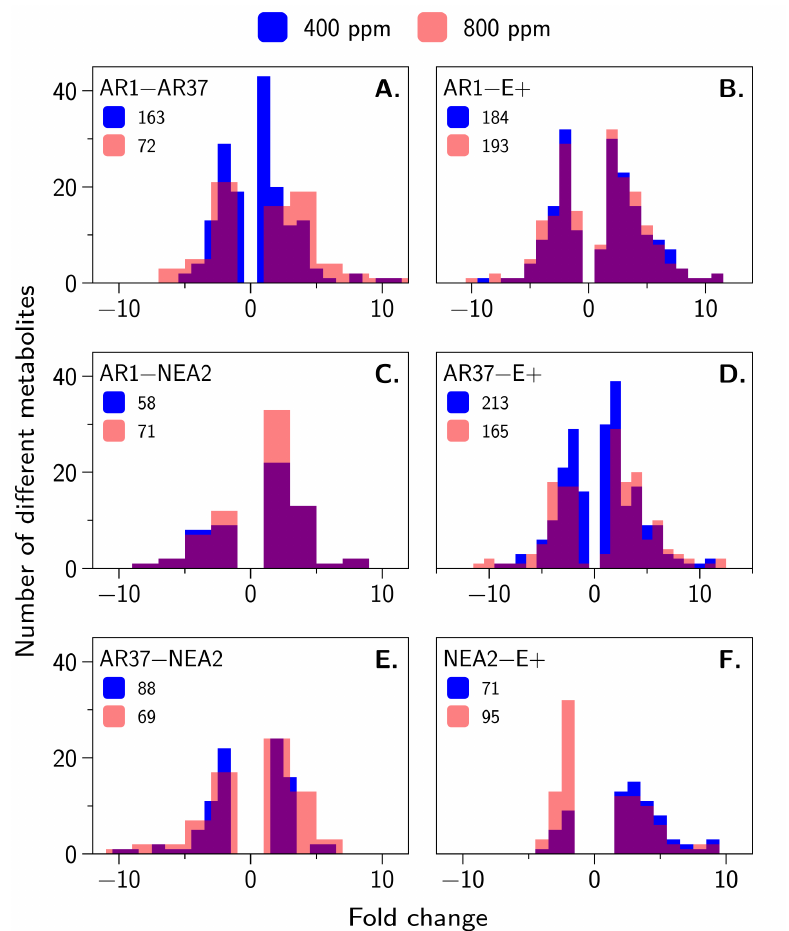
Figure 4. Distribution of magnitude of metabolite abundance differences. Shown are the distributions of the magnitudes of metabolite abundance differences between different endophyte strains at ambient CO 2 (blue bars) and elevated CO 2 (pink bars). Areas where the two distributions overlap is shown in purple. The numbers in the legends indicate the total number of metabolite differences for that comparison. ( A ) denotes the fold change differences of AR1 − AR37; ( B ) denotes the fold change differences of AR1 − E + ; ( C ) denotes the fold change differences of AR1 − NEA2; ( D ) denotes the fold change differences of AR37 − E + ; ( E ) denotes the fold change differences of AR37 − NEA2; and ( F ) denotes the fold change differences of NEA2 − E +